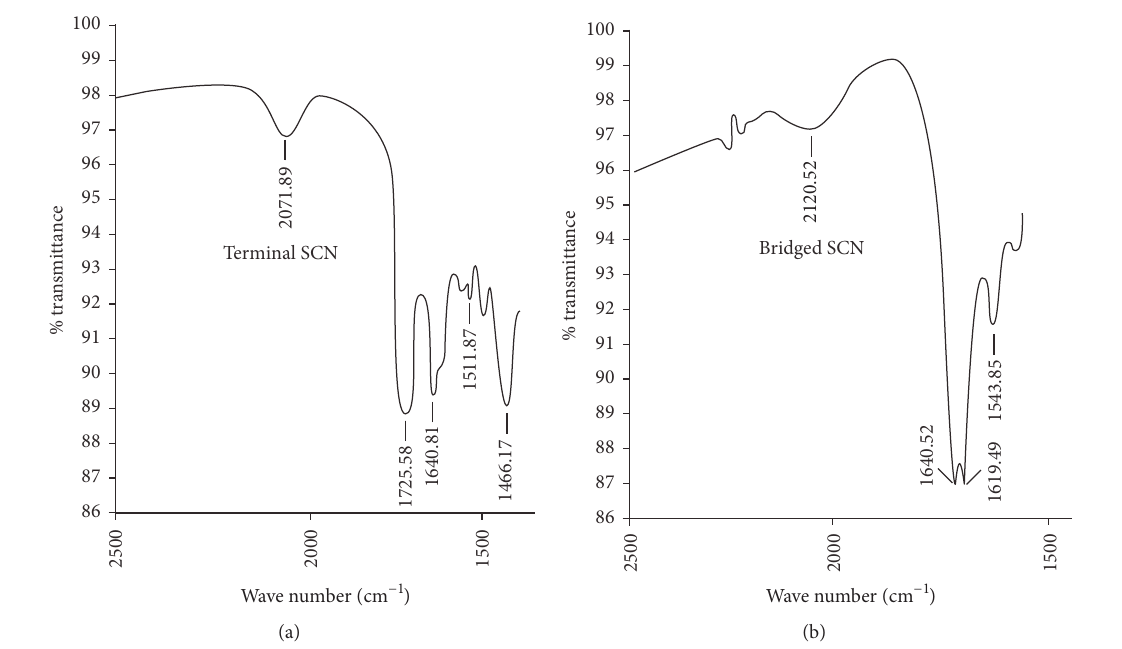
Figure 2: IR spectra of (a) K[Fe III (Pc)(SCN) 2 ] and (b) [ Fe III ( Pc )( SCN )] 𝑛